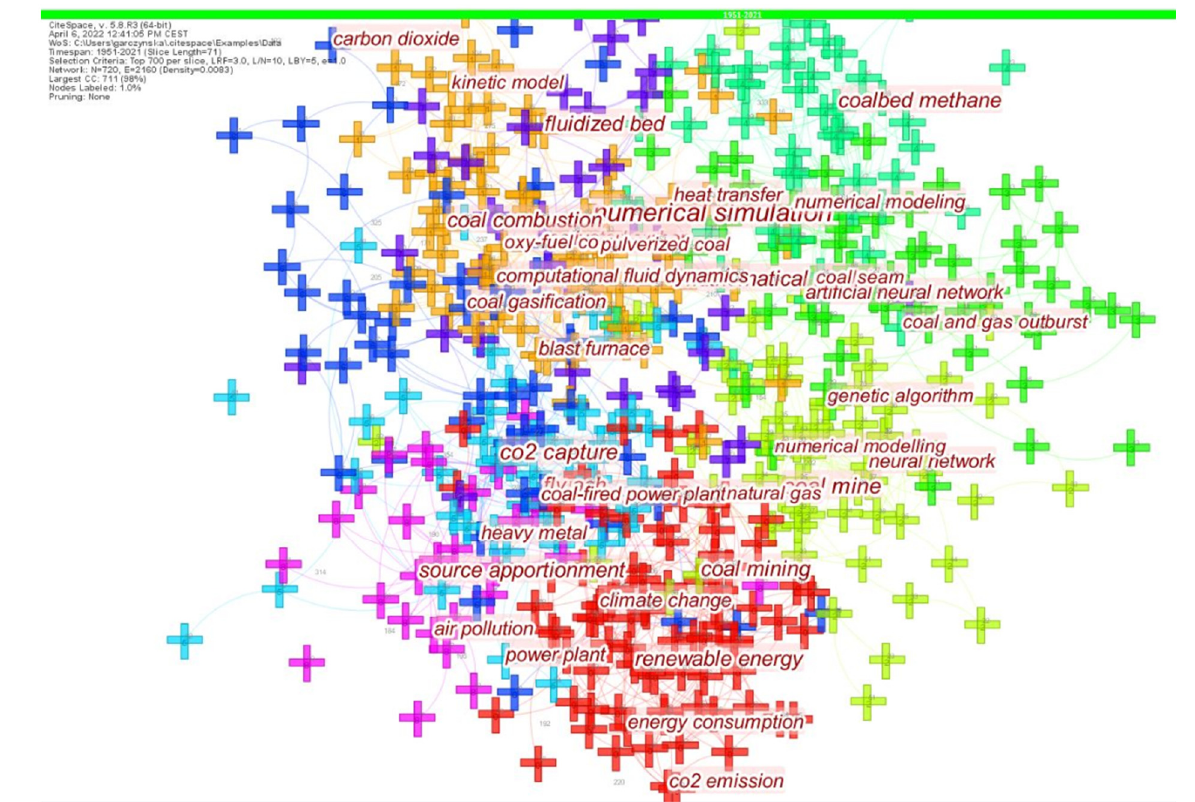
Figure 13. Authors’ key words for WoS categories.